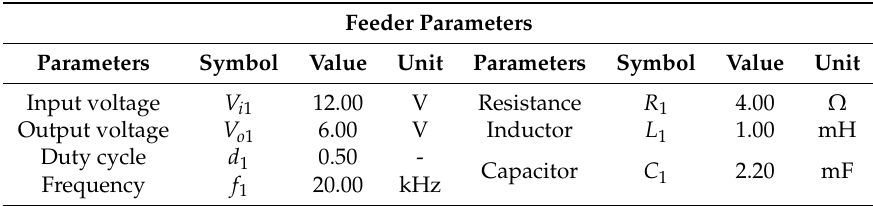
Table 1. Buck converter parameters operating as